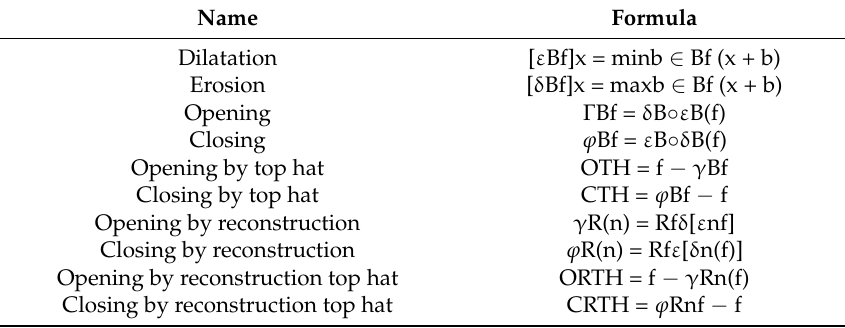
Table 2. Mathematical morphology formulae for image f and structuring element (SE) B for a pixel x. For further details see